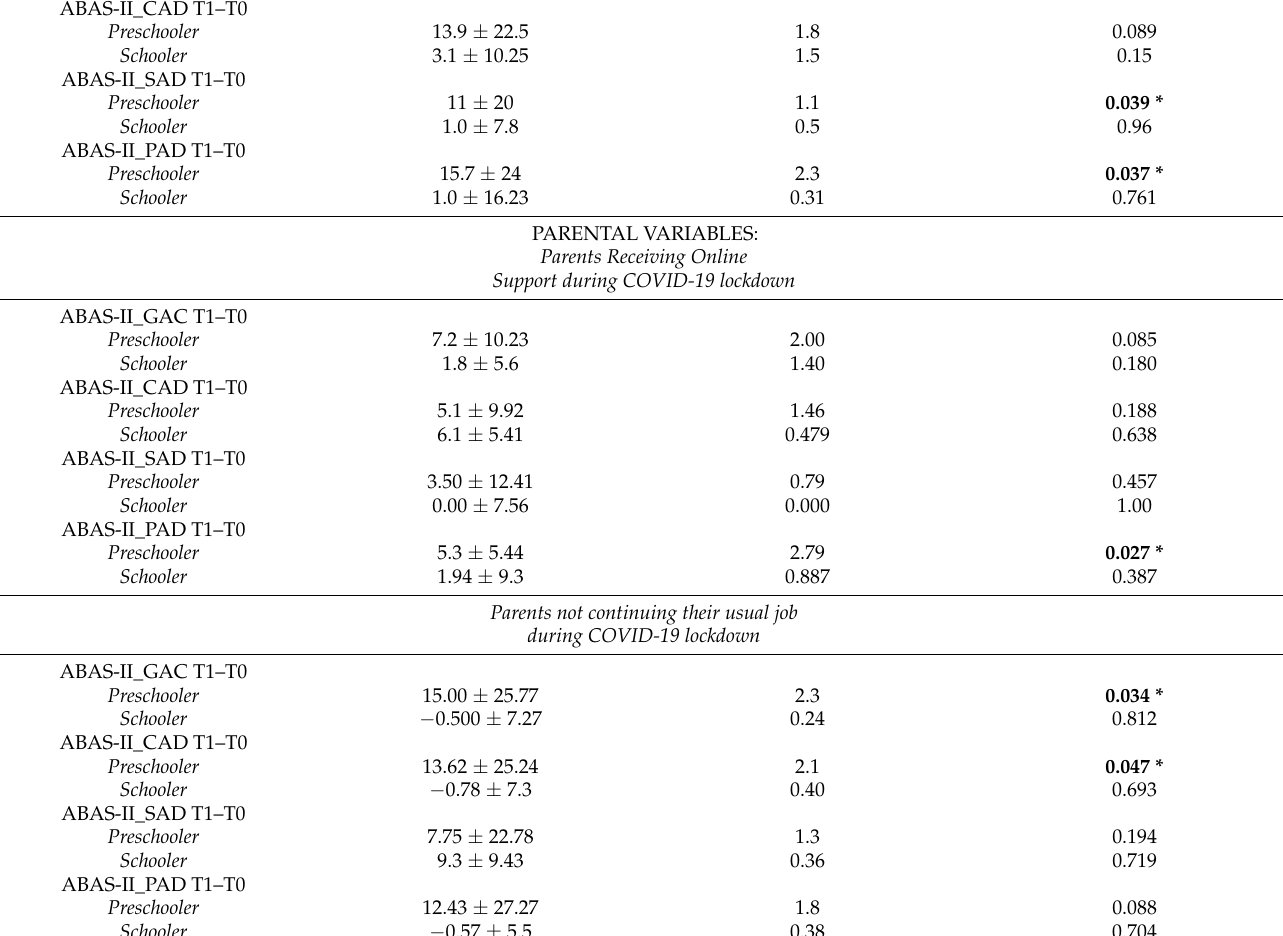
Shown in the Table are the impact of the child (children receiving online intervention during the lockdown, children without intellectual disability) and parental variables (parents receiving online parental support ; parents not continuing their usual job during the lockdown either in person or remotely) on adaptive skills the difference T1–T0. Legend: ABAS-II = Adaptive Behavior Assessment System (Second Edition); GAC = general adaptive composite score; CAD = conceptual adaptive domain; SAD = social adaptive domain; PAD = practical adaptive domain; * = significant